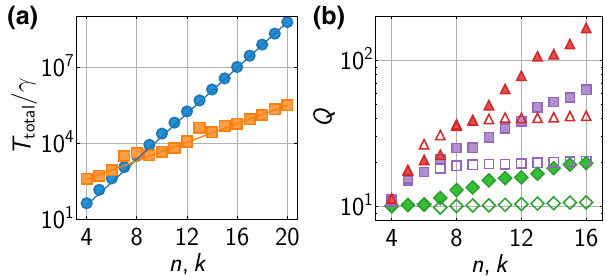
FIG. 7. Comparison of the recursive and standard algorithms. (a) Physical time T total /γ to implement all T total queries of the oracle at fixed J max , plotted versus n = k . Blue circles show the standard algorithm with γ = γ c . Orange squares show recur- sive algorithm with m = 6 and γ = 2 − m − 1 . Lines denote scal- ings 2 α n , with α = 1.5 for the standard algorithm and α = 0.5 + 0.65 / m for the recursive algorithm. (b) Speedup Q ver- sus n = k for standard algorithm (open markers) and recursive algorithm (solid markers) at interaction-to-decay ratios ρ = 10 3 (green diamonds), ρ = 10 4 (purple squares), and ρ = 10 5 (red